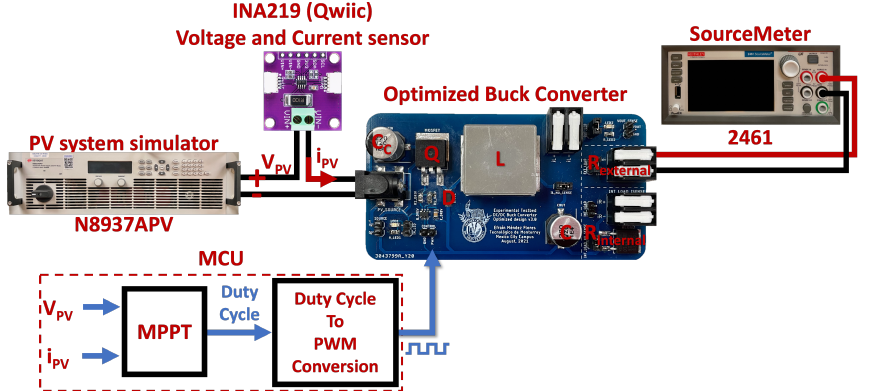
Figure 26. Case study topology with the N8937APV PV array simulator, 2461 SourceMeter®, and the optimized buck converter integrated with the INA219 (Qwiic) power sensor.